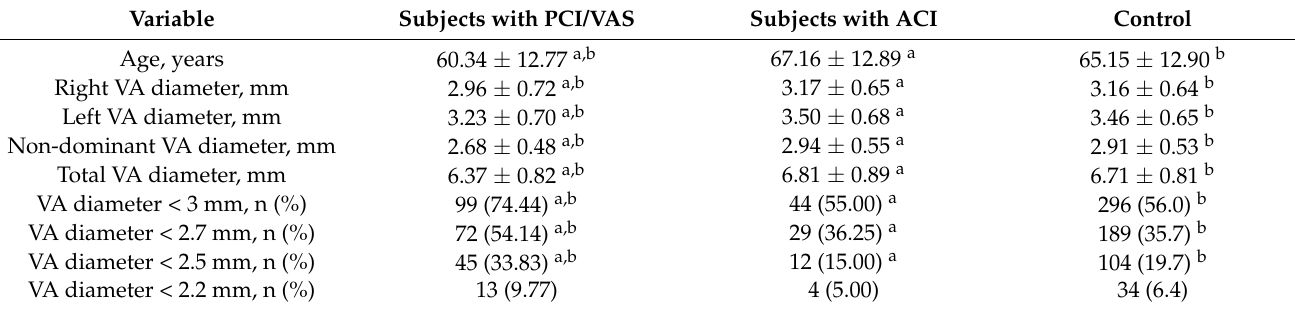
Table 1. Vertebral artery diameter and prevalence of vertebral artery hypoplasia in subjects with PCI/VAS, ACI and subjects without symptoms of cerebrovascular